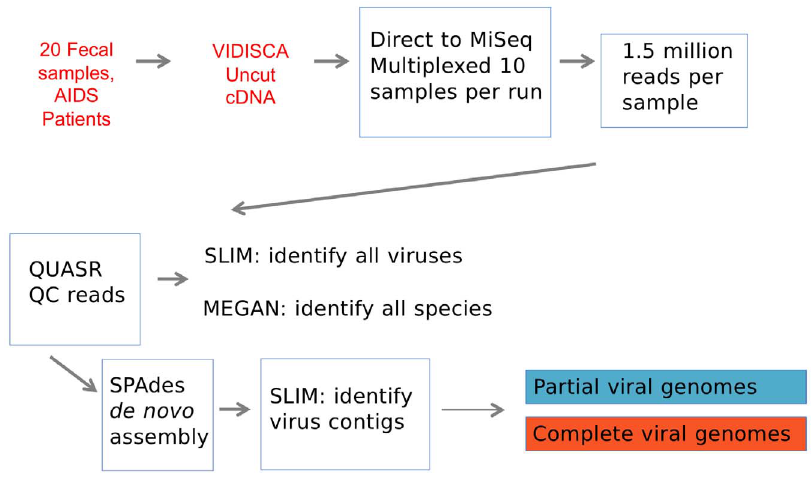
Figure 1. An overview of the ViSeq process.